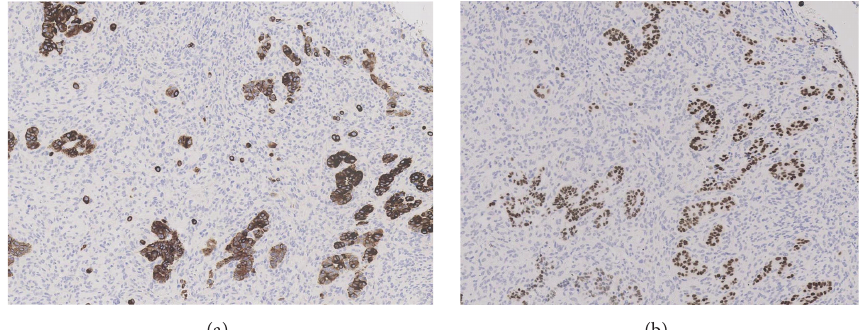
Figure 6: Immunohistochemical stains CK7 and TTF-1 expressed only by the glandular component highlighting the biphasic nature of the tumour ( × 10 objective).